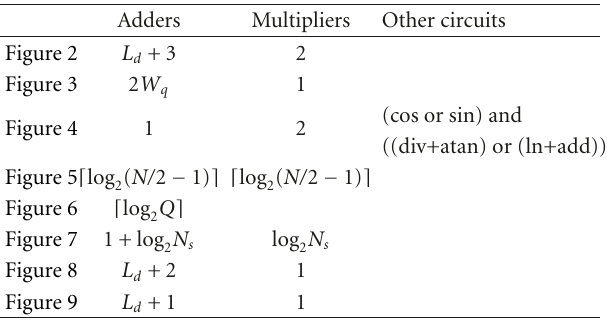
Table 2: The longest path of parallel realization.